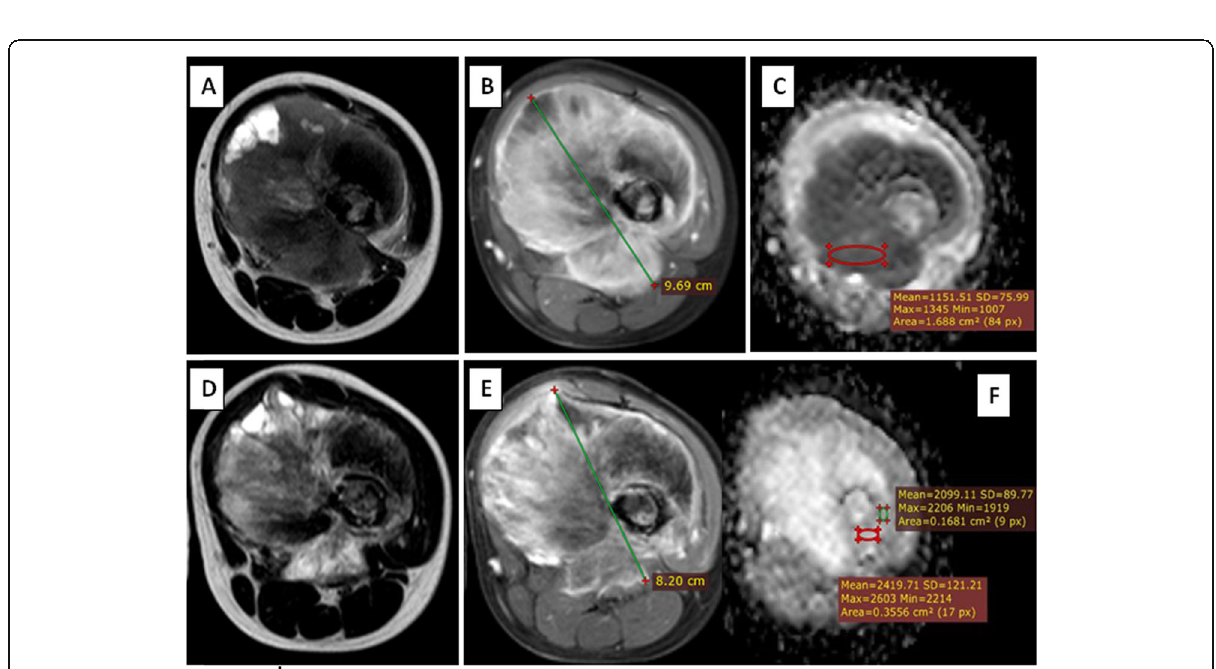
Fig. 3 A 7-year-old female with osteosarcoma in the left femur. MR images a – c before and d – f after chemotherapy. a , b Axial T2-WI and post contrast-enhanced T1-WI showing left femur intra medullary infiltrative lesion with circumferential soft tissue mass eliciting heterogeneous mixed signal in T2 and heterogeneous contrast uptake. c ADC map showed diffusion restriction with mean ADC values of the most restricted ROIs about (mean, 1.1 × 10 − 3 mm 2 /s). d , e Follow-up axial T2-WI and contrast-enhanced T1-WI showing minimal size regression with heterogeneous enhancement. f Follow-up ADC map showing elevated ADC values (mean, 2.30 × 10 − 3 mm 2 /s) denoting good therapeutic